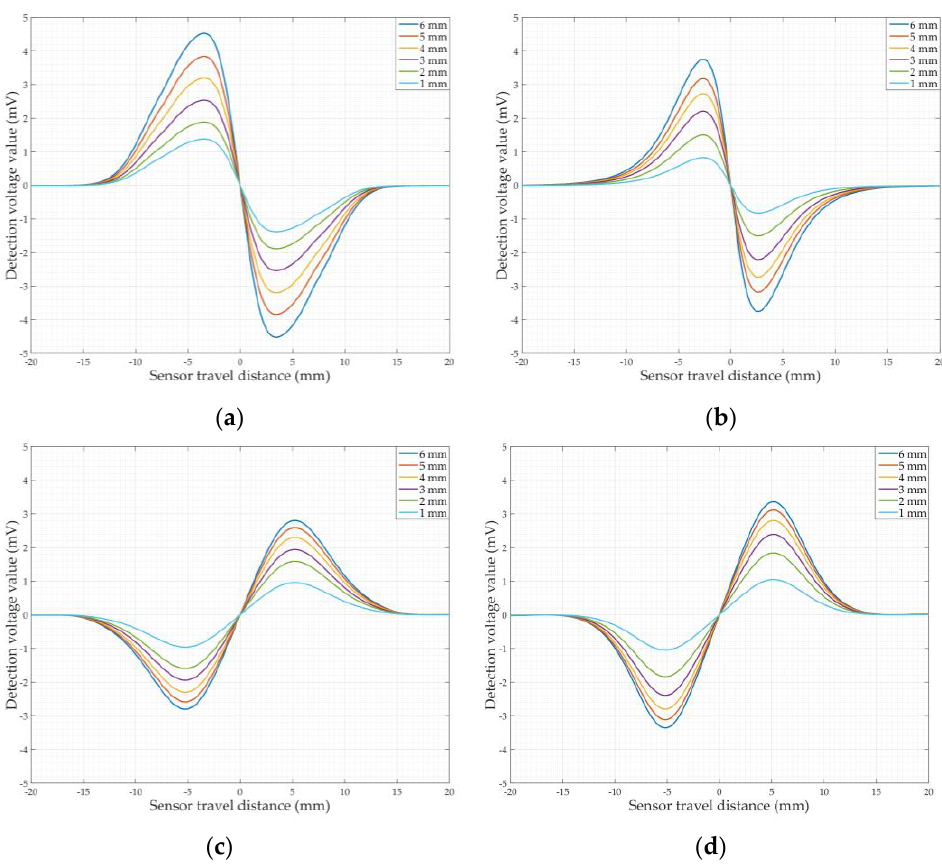
Figure 6. Simulation detection signals of cracks: ( a ) In-phase components of the circumferential crack detection signals; ( b ) Orthogonal components of the circumferential crack detection signals; ( c ) In-phase components of the axial crack detection signals; ( d ) Orthogonal components of the axial crack detection signals.